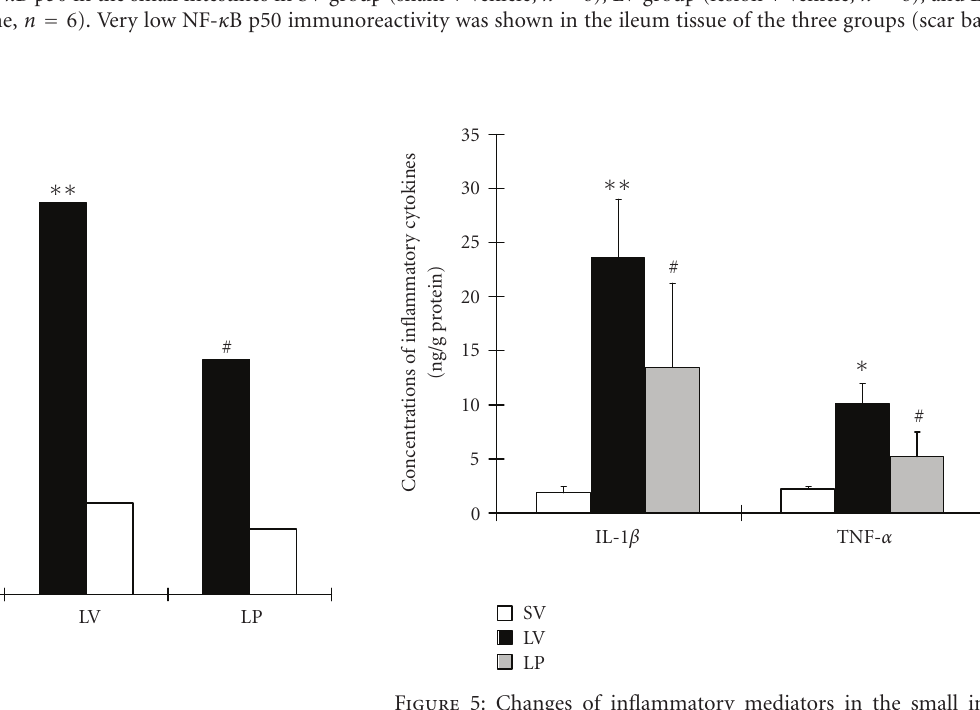
progesterone induced the transcription of A20 and ABIN-2 through PRB, resulting in the inactivation of free NF- κ B in the cytoplasm.